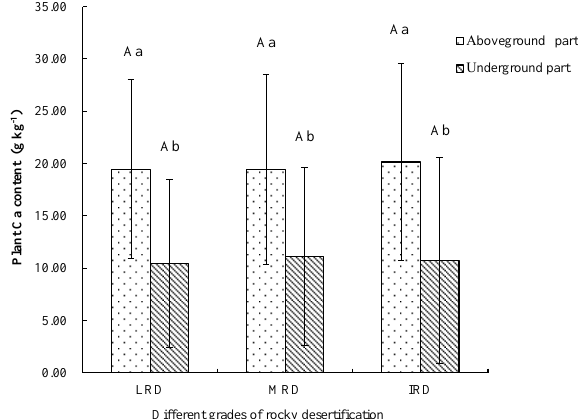
Figure 2. Characteristics of plant Ca content in different grades of rocky desertification. LRD: light rocky desertification; MRD: mod- erate rocky desertification; IRD: intense rocky desertification. Dif- ferent lowercase letters represent significant differences in the Ca content between the aboveground and belowground parts of the plants in the same grade of rocky desertification; different upper- case letters represent significant differences in the Ca content of the plants among the different grades of rocky desertification ( p